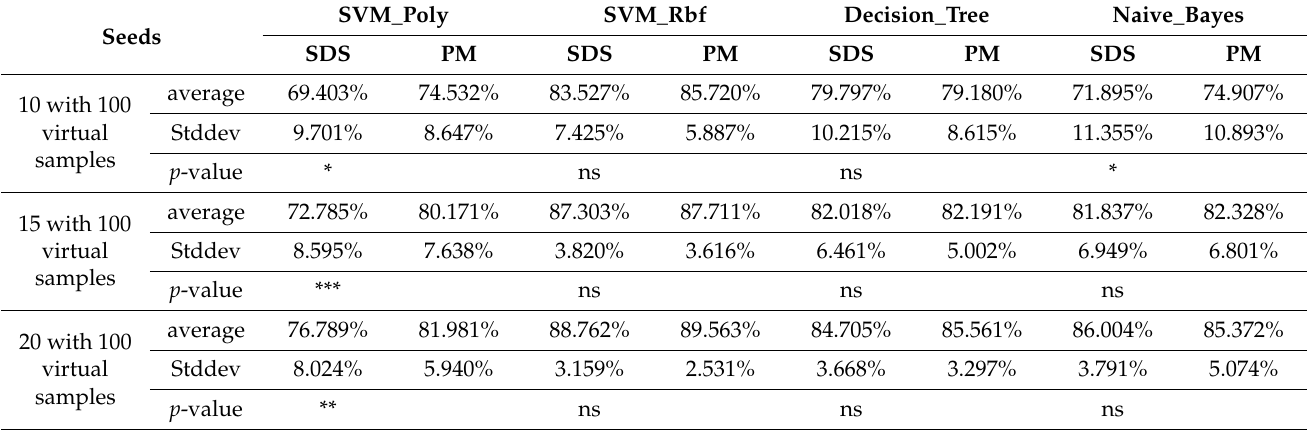
Table 4. The result of generating 100 virtual samples by WGAN_MTD for the Seeds dataset.